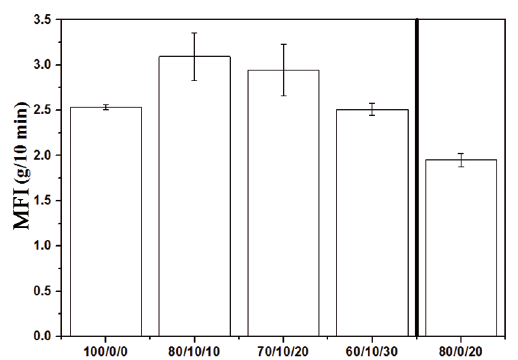
Figure 2: Melt flow index of PPr and PPr-based composites.